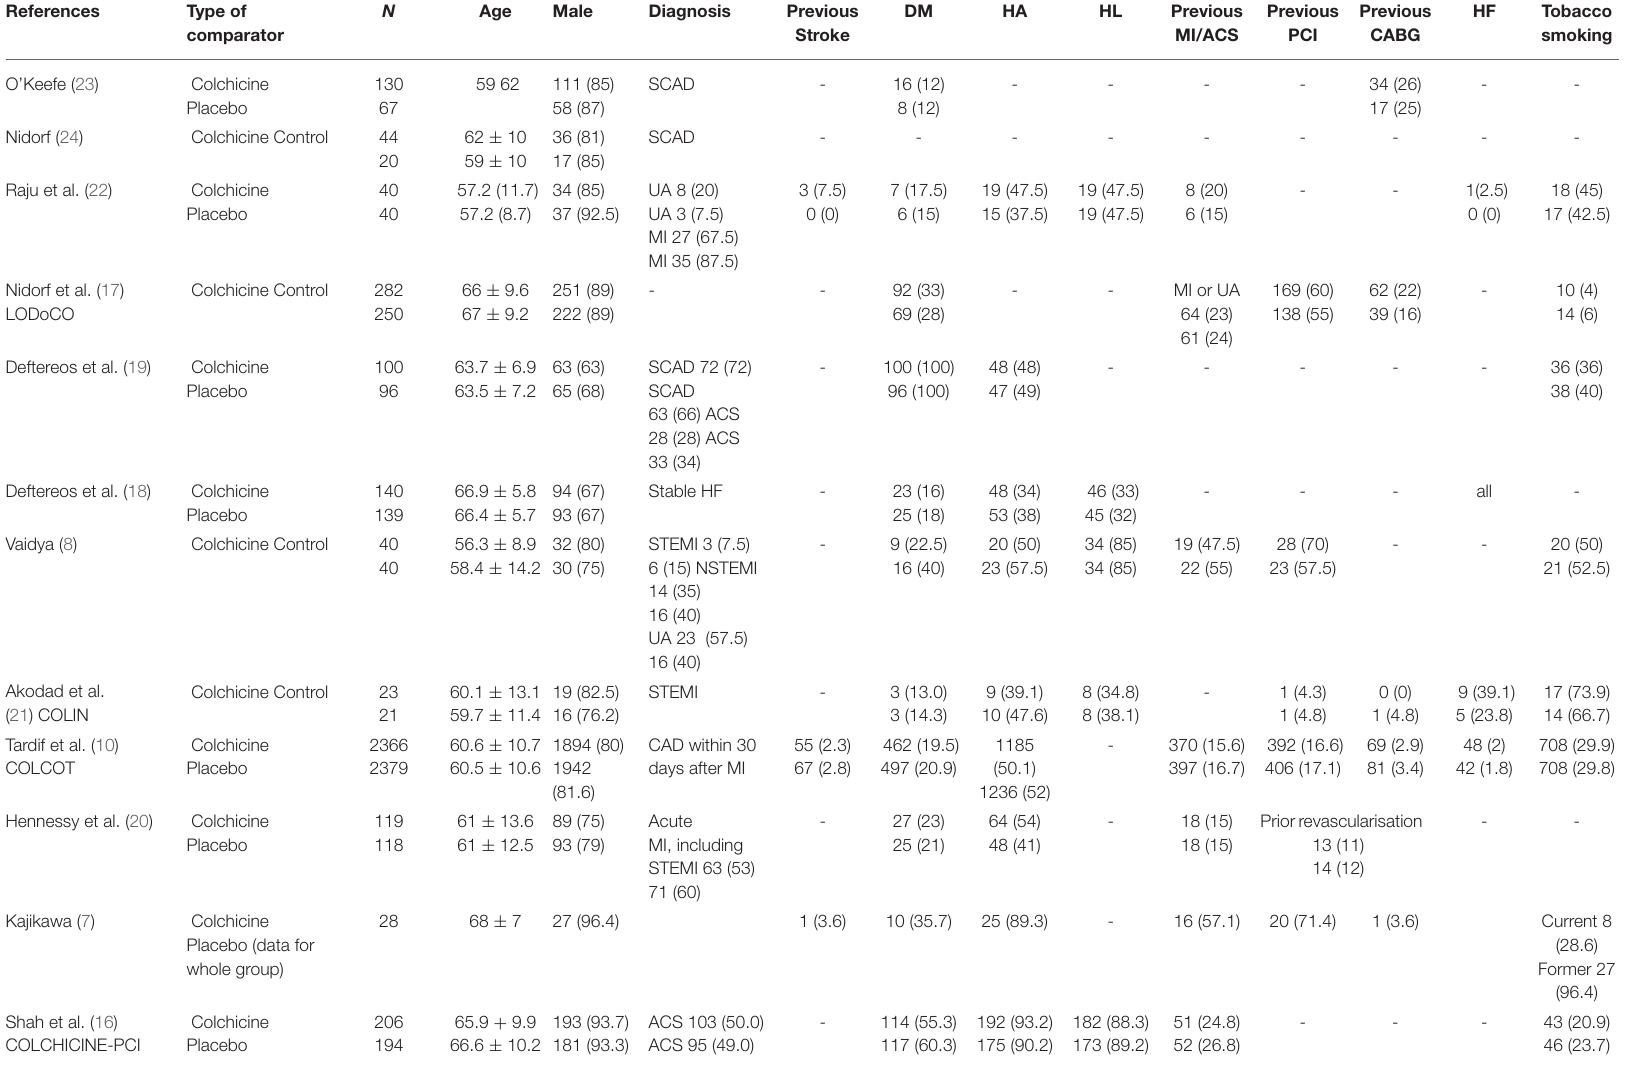
TABLE 2 | Baseline patient